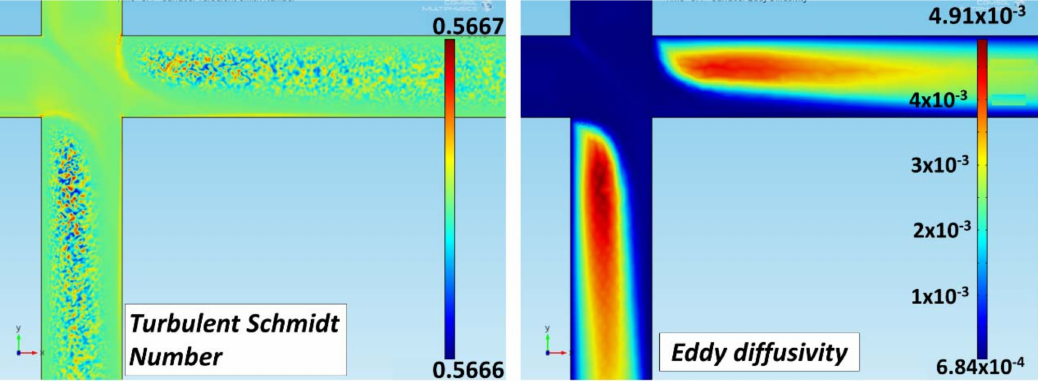
Figure 12. Sc T and eddy diffusivity plots based on the Kays-Crawford [41] model (Equation (12)). High values appear in the turbulent flow